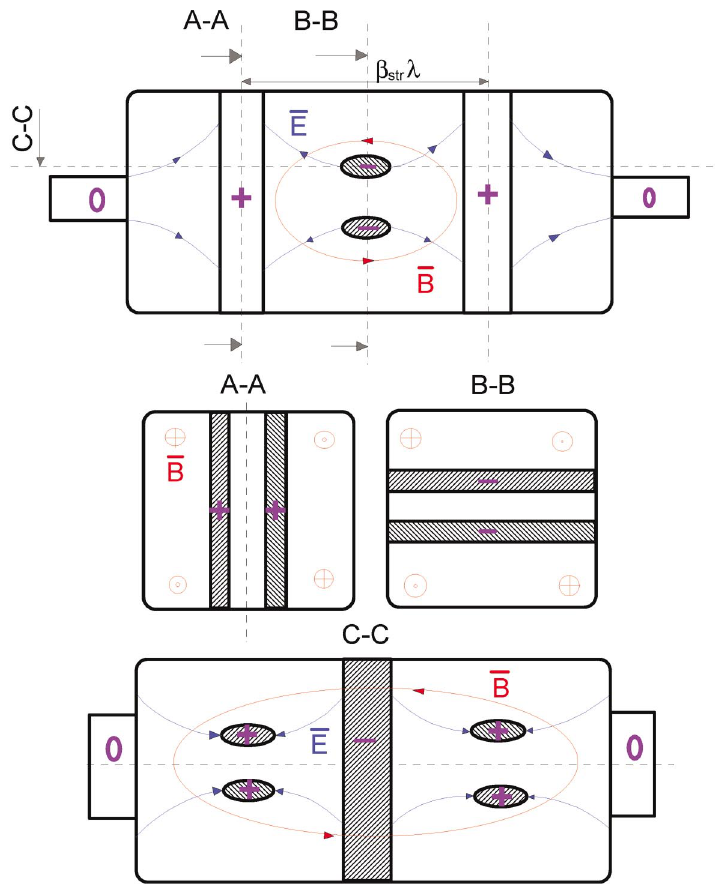
FIG. 3. (Color) Field picture in the slot resonator.